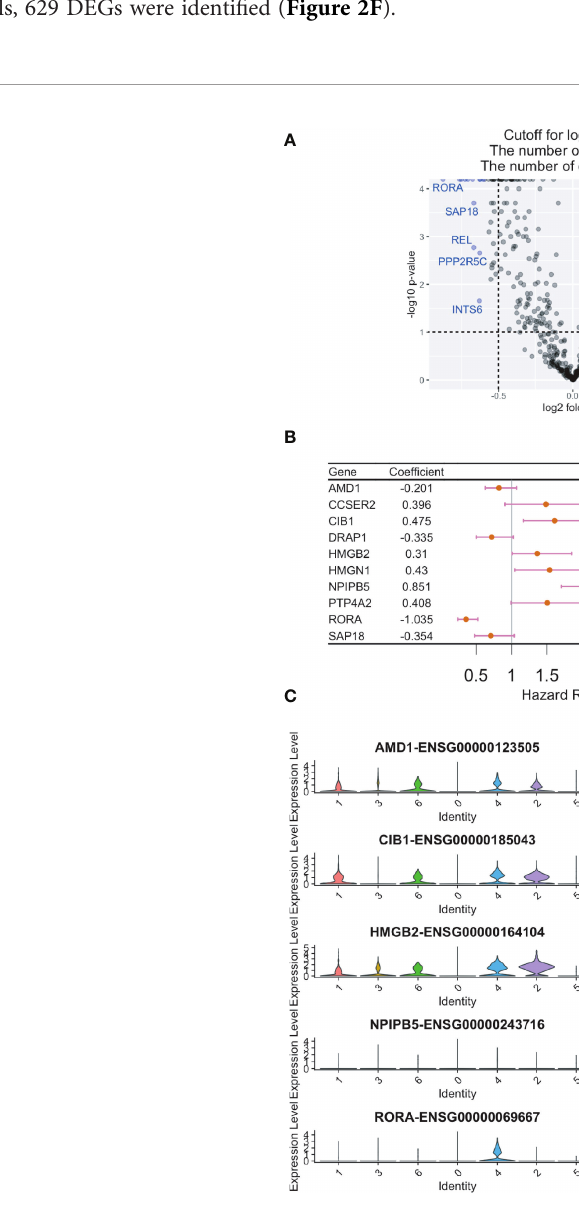
FIGURE 3 | Construction of a CD8+ T cell-related prognostic gene signature for clear cell renal cell carcinoma (ccRCC). Cox regression analysis was used to build a CD8+ T cell-related prognostic gene signature. (A) Volcano plot showing the Cox regression analysis results of CD8+ T cell DEGs (ccRCC vs. papRCC). DOWN, down-regulated; NOT, not signi fi cant; UP, up-regulated. (B) Forest plot showing the top ten genes selected by random survival forest algorithm. (C) Violin plots showing the expression of the ten genes in different cell